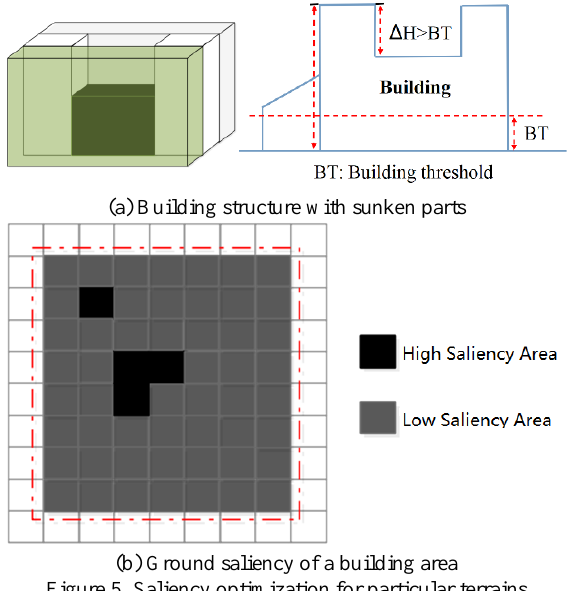
Figure 5. Saliency optimization for particular